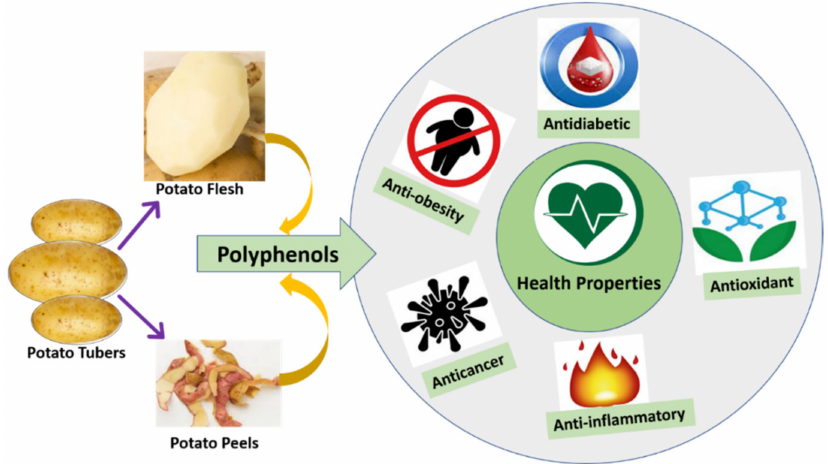
Figure 2. Various biological activities concerning with polyphenols extracted from potato flesh and